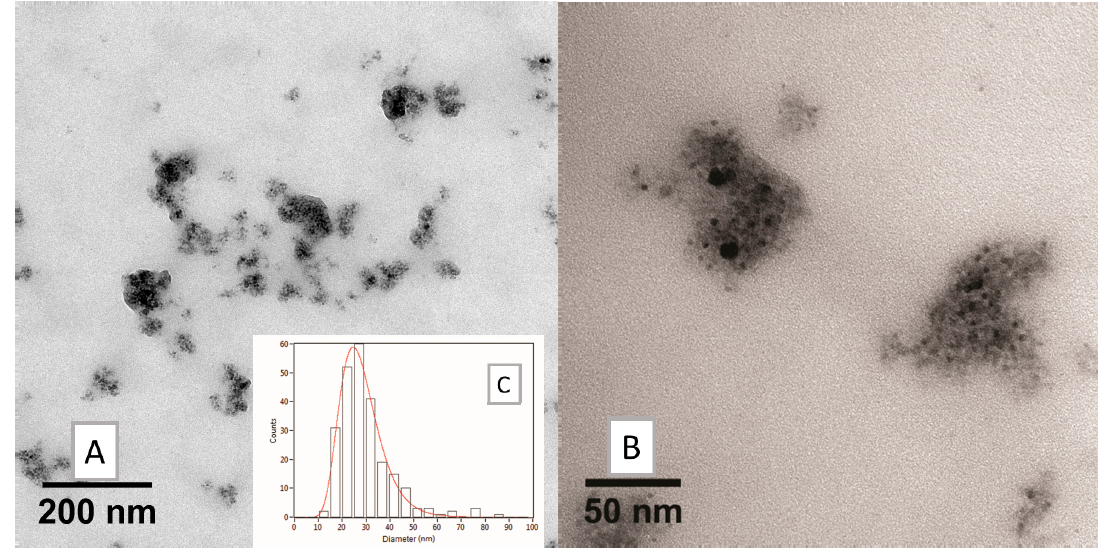
Figure 11. TEM analysis on SPION4: ( A ) low and ( B ) high magnification bright field micrographs, and ( C ) size distribution histogram of the nanosystems.